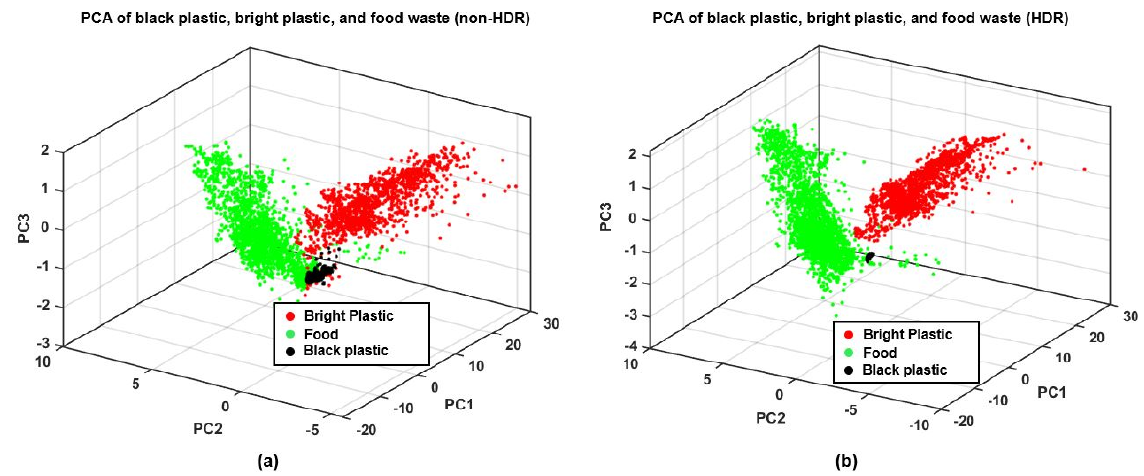
Figure 11. PCA plots for food and plastic: ( a ) non-HDR, ( b ) HDR.